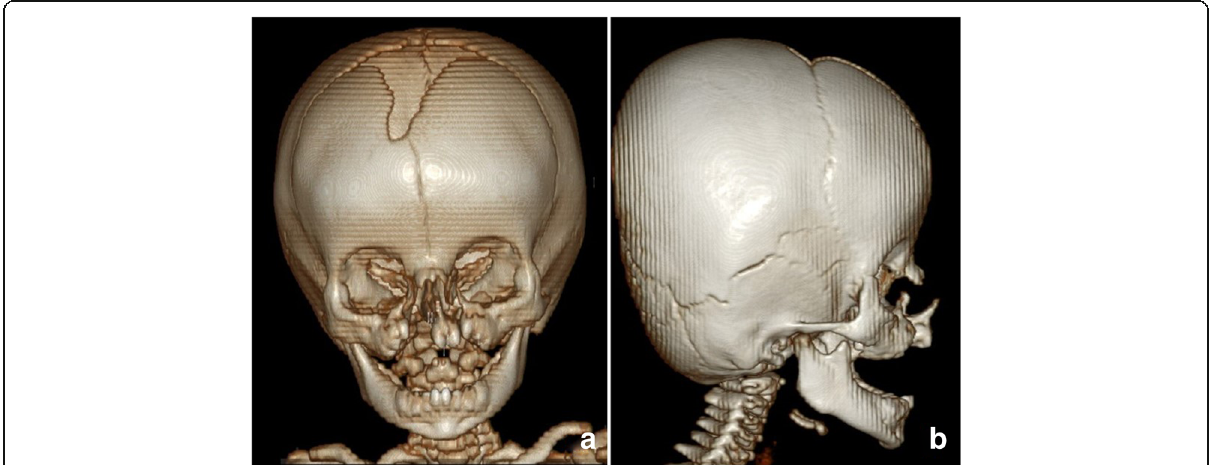
Fig. 2 3D CT views. a The frontal view demonstrated corresponding bony clefts extended from the alveolus, through the nasomaxillary sutures, and up to the inferomedial walls of the orbits. b The lateral view demonstrated a protruding